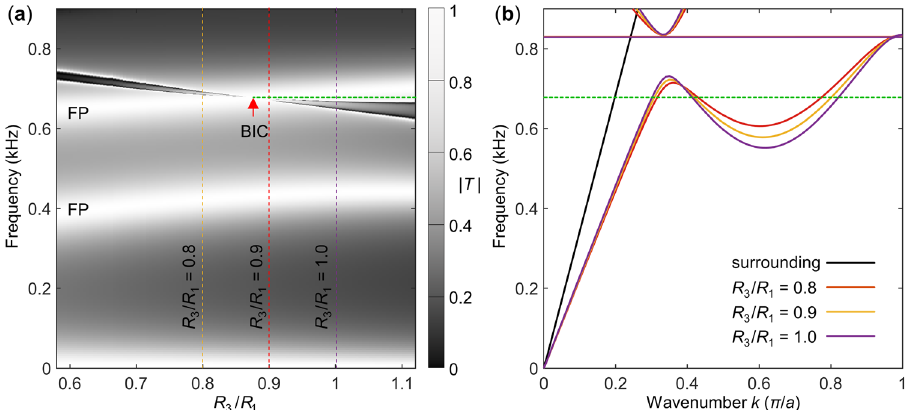
Fig. 9 Phonon transmission results of the designed metamaterial. a Numerically obtained transmission spectrum T j j for the metamaterial structure = R shown in Fig. 8b versus exciting frequency ω = ð 2 π Þ and versus the ratio R . Damping is neglected. The bound-states-in-the-continuum (BIC) point is 3 1 marked by the red arrow. b Calculated phonon dispersion relation for three selected ratios R 3 = R 1 (see legend). The lowest acoustic band exhibits a pronounced roton-like behavior. For comparison, the dispersion relation of the surrounding (a straight line) is depicted by the black solid curve. bottom of the model to mimic an incident plane wave. A perfectly matched layer is employed at the top to mimic a semi-in fi nite transmission region with no re fl ections 43 . All other boundaries